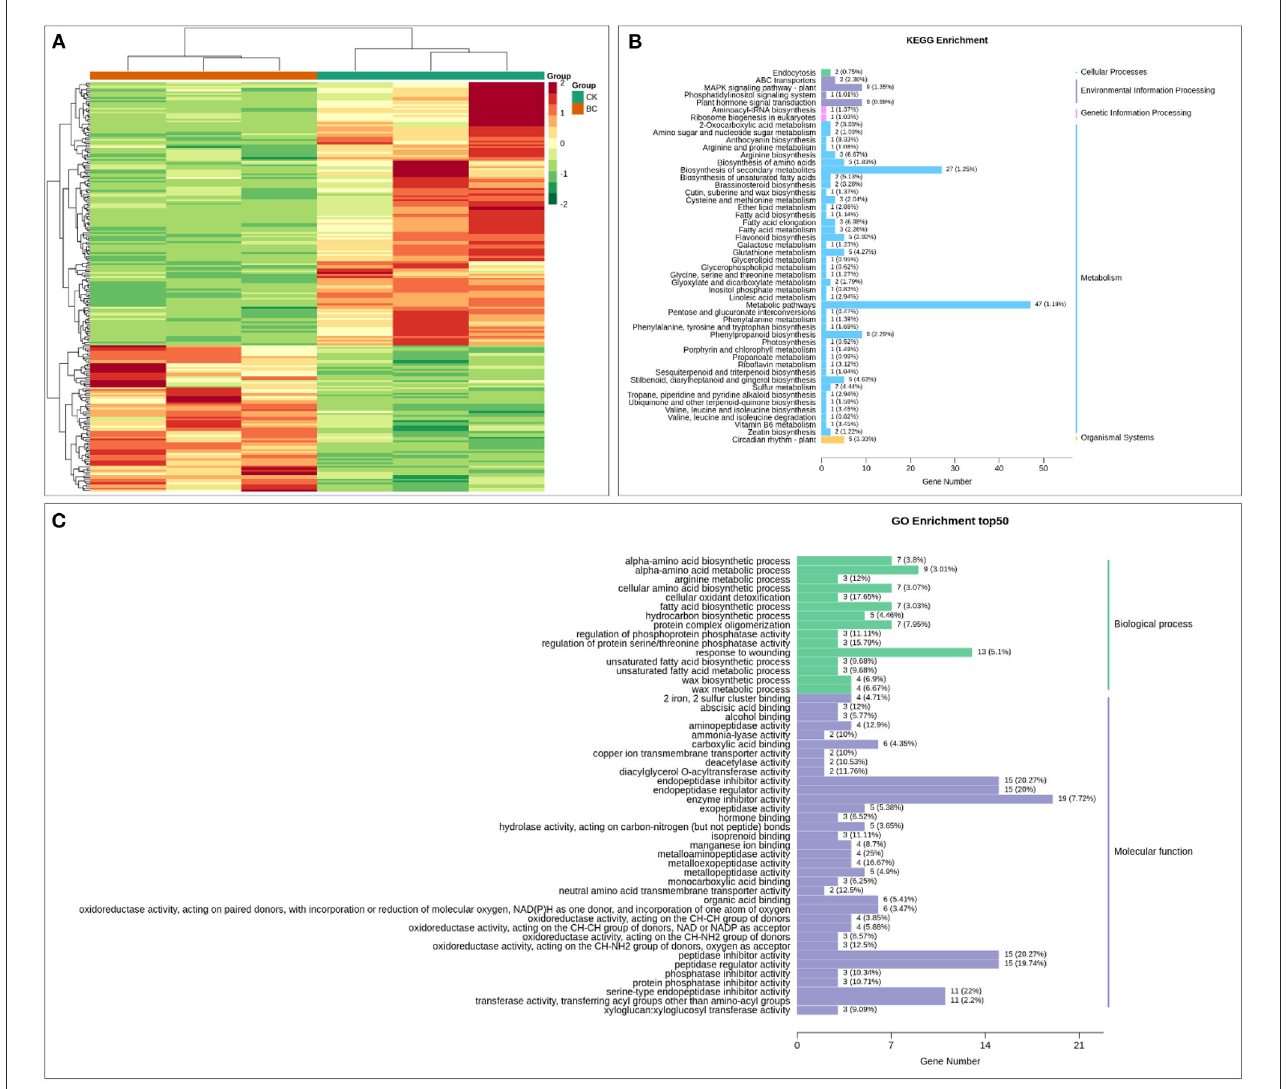
FIGURE5 (A) Heatmap of FPKM values of the differentially expressed genes in CK vs. BC. Enrichment of the differentially expressed genes in CK vs. BC in (B) KEGG and (C) GO